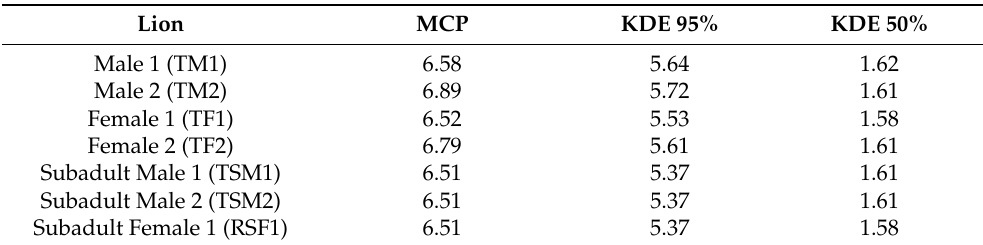
Table 3. Summary of individual home range size per lion (100% MCP, 95% KDE; 50% KDE), for the Tsau pride, at the Tula-Tsau Conservation Area, South